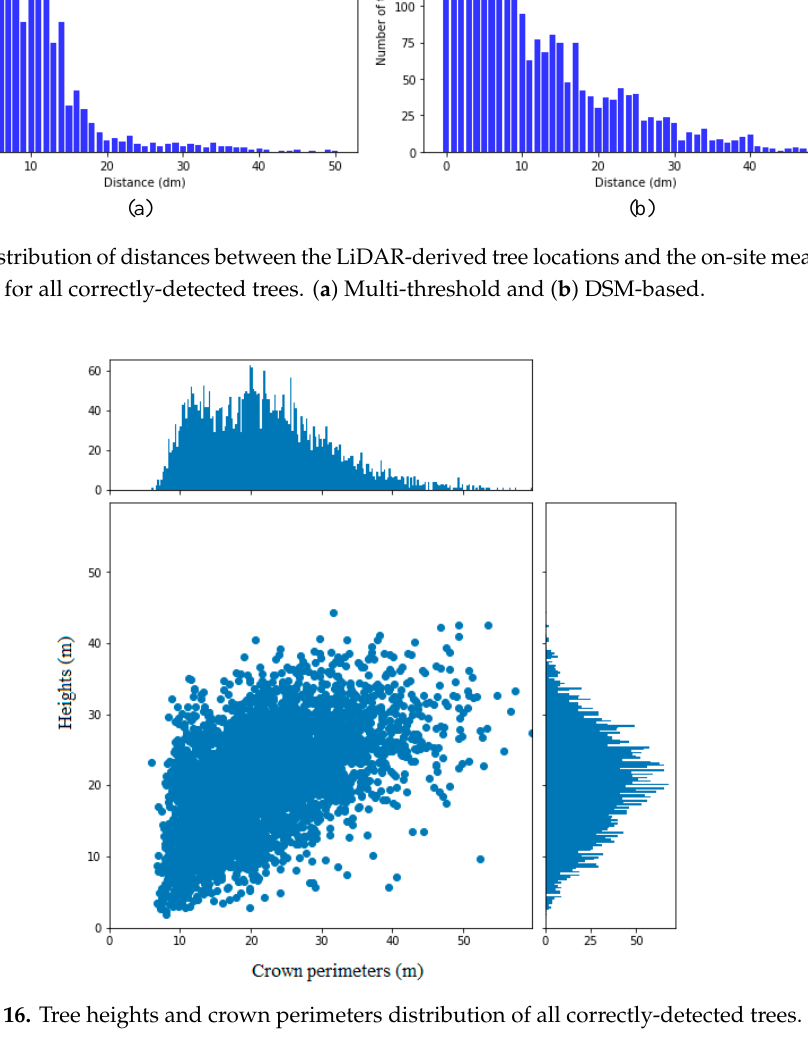
Figure 16. Tree heights and crown perimeters distribution of all correctly-detected trees.